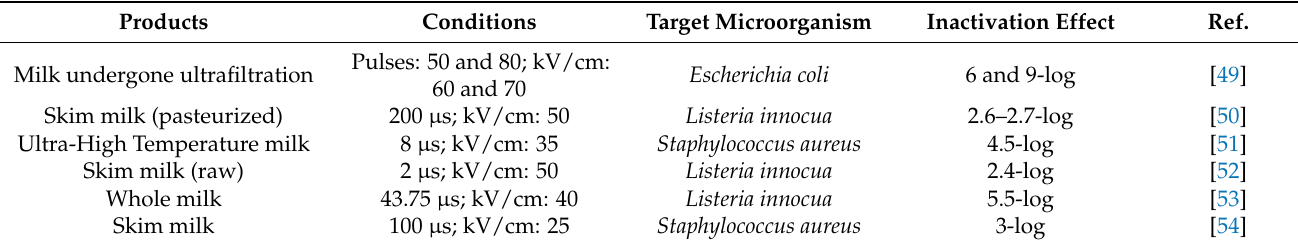
Table 2. Inactivation of microorganisms by pulsed electric field (PEF) processing in milk and milk products.